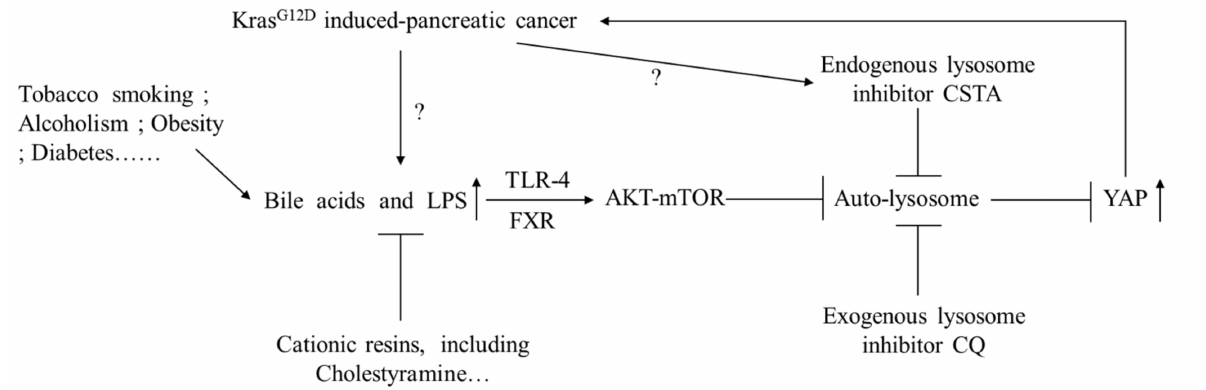
Figure 9. Hypothetical figure. Kras G12D mutation and pancreatic cancer risk factors, such as obesity and diabetes, can induce hyperbileacidemia and hyperendotoxemia, which promote pancreatic cancer progression via inhibiting autophagic flux for YAP degradation. Cationic resins like cholestyramine can restrict pancreatic cancer progression by sequestering intestinal acidic toxins. CQ: chloroquine; FXR: Farnesoid X receptor; TLR-4: Toll-like receptor 4; CSTA: Cystatin A; YAP: Yes-associated